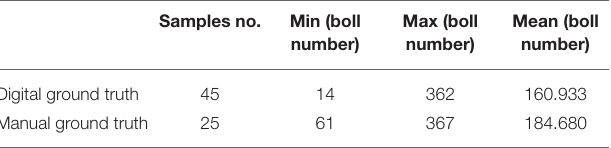
TABLE 1 | Ground truth data summary. Samples